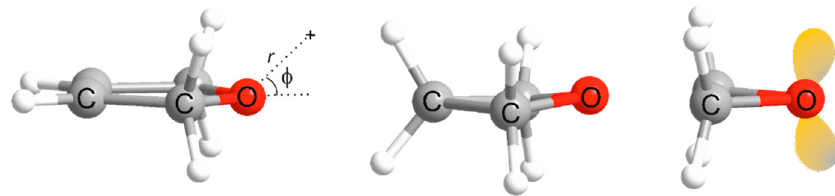
Figure 3. The cyclic ethers 2,5-dihydrofuran, oxetane and oxirane. The n-pairs on O in oxirane are drawn in the exaggerated form often used by chemists.